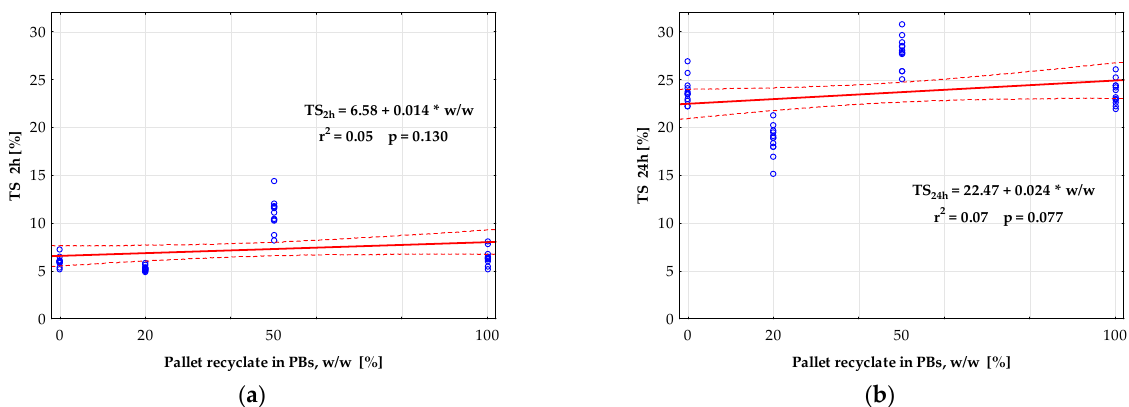
Figure 5. Thickness swelling (TS) after 2 h ( a ) and 24 h ( b ) of PBs containing different amount of particles from recycled spruce pallets (RSP).